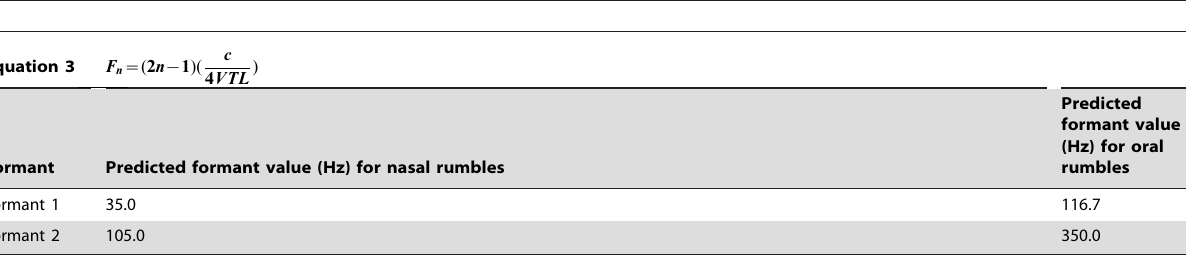
Table 2. Predicted formant values of oral and nasal rumbles in African elephants (after [26]).